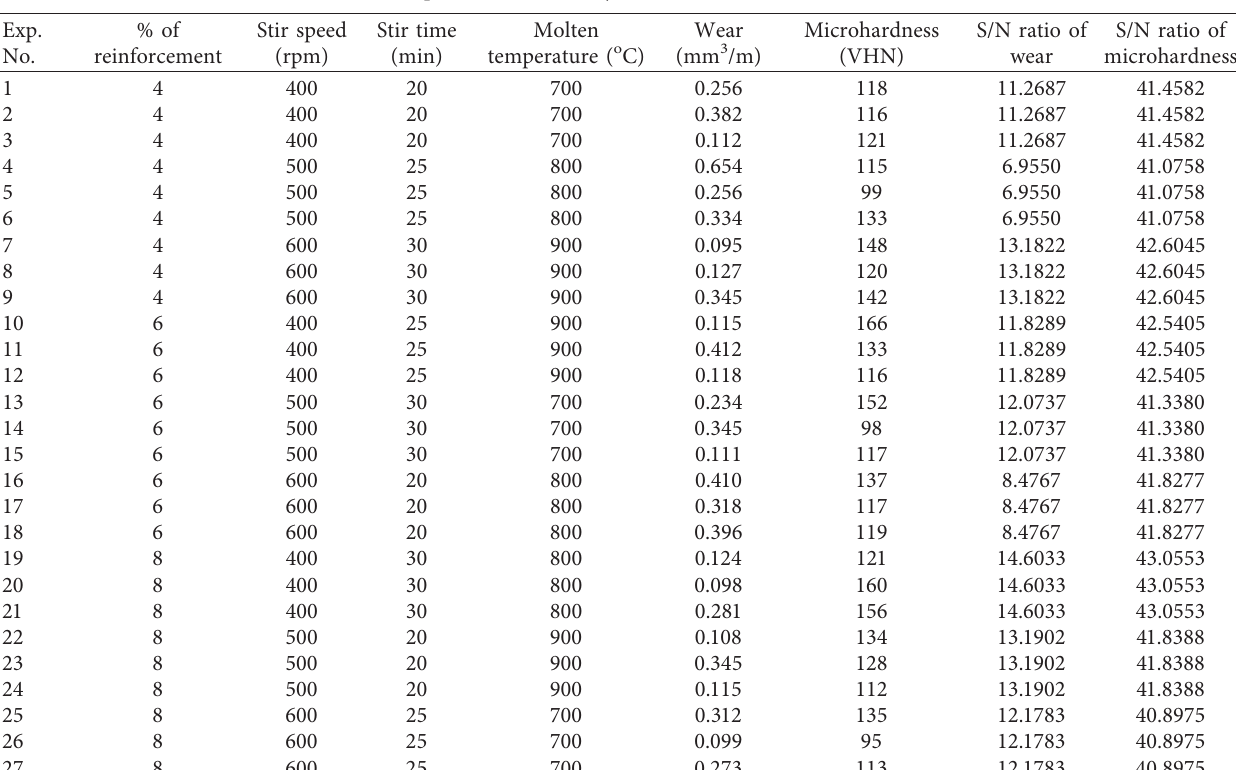
Table 3: Experimental summary of wear and microhardness tests.